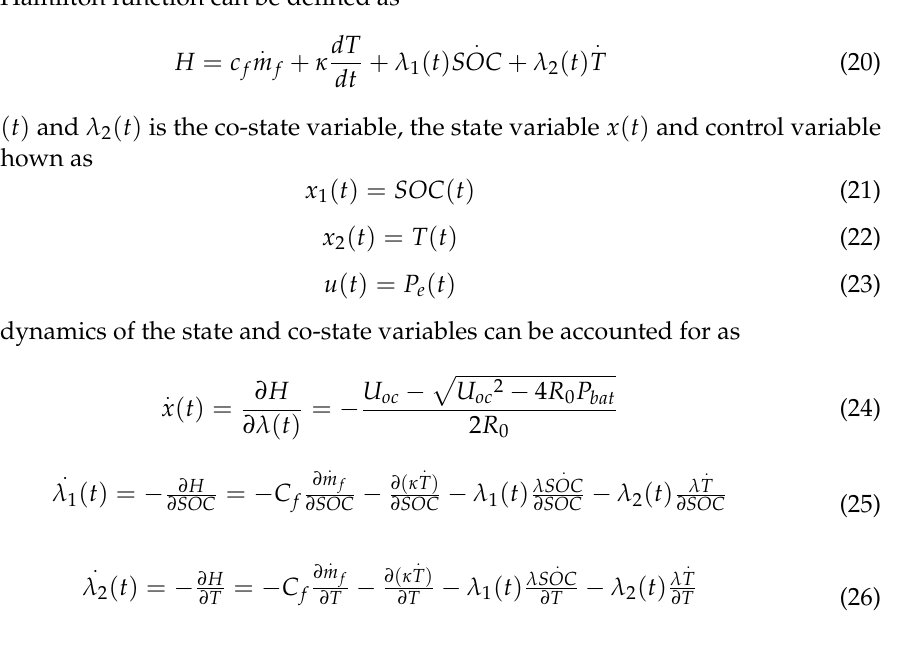
Figure 8. Influence of weighting factor